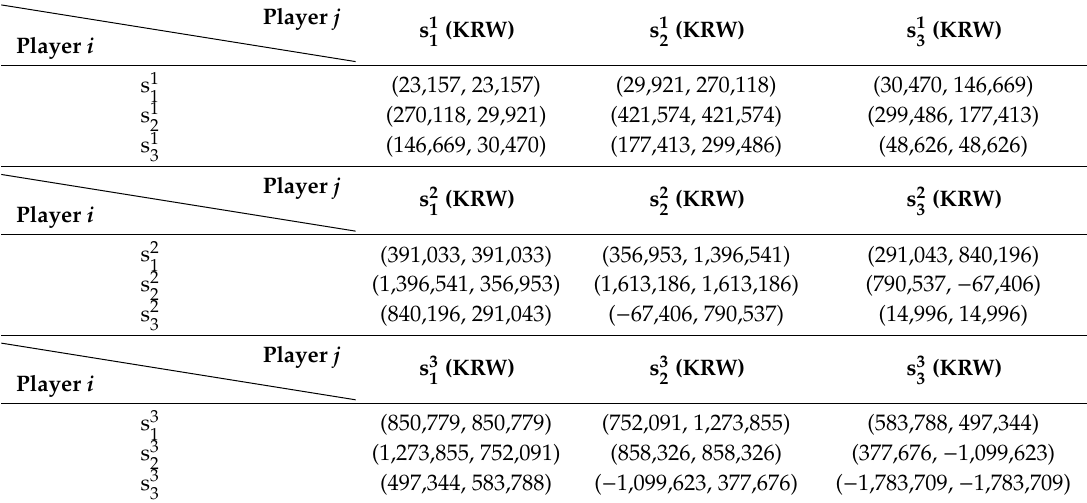
Table 5. Results of the game with Scenario 1, Scenario 2, and Scenario 3.